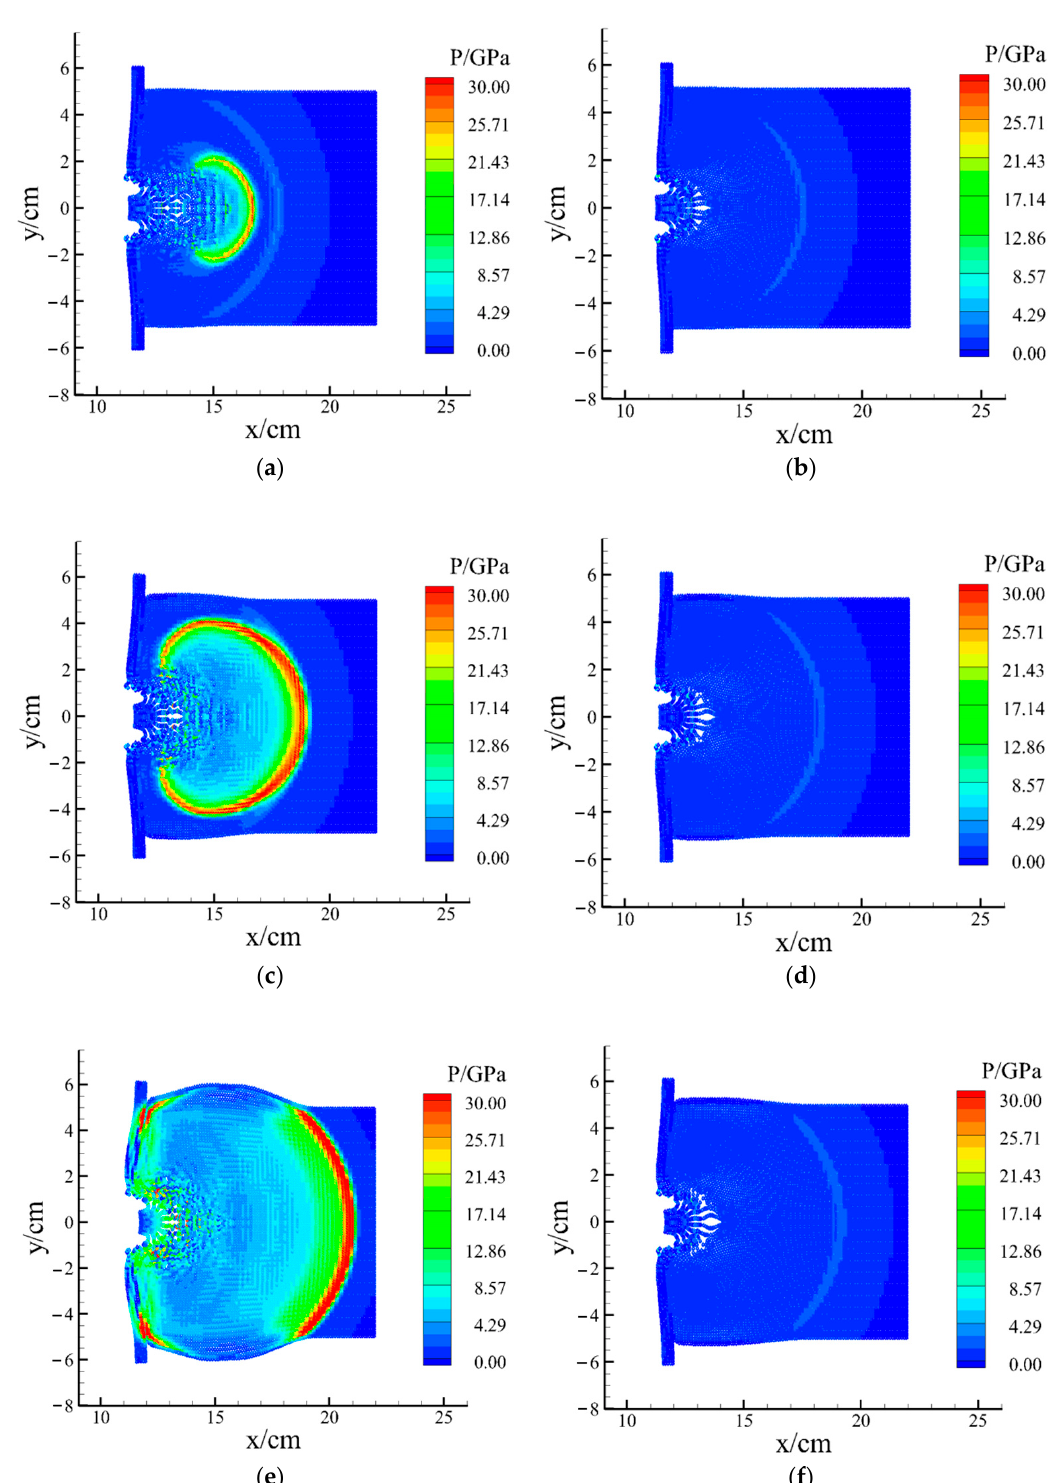
Figure 5. The color contour plots of the pressure when the v ’s are 1003.5 m/s and 1049.8 m/s, respec- tively. ( a ) The contour plot when t = 22 μ s, v = 1049.8 m/s. ( b ) The contour plot when t = 22 μ s, v = 1003.5 m/s. ( c ) The contour plot when t = 25 μ s, v = 1049.8 m/s. ( d ) The contour plot when t = 25 μ s, v = 1003.5 m/s. ( e ) The contour plot when t = 28 μ s, v = 1049.8 m/s. ( f ) The contour plot when t = 28 μ s, v = 1003.5 m/s.